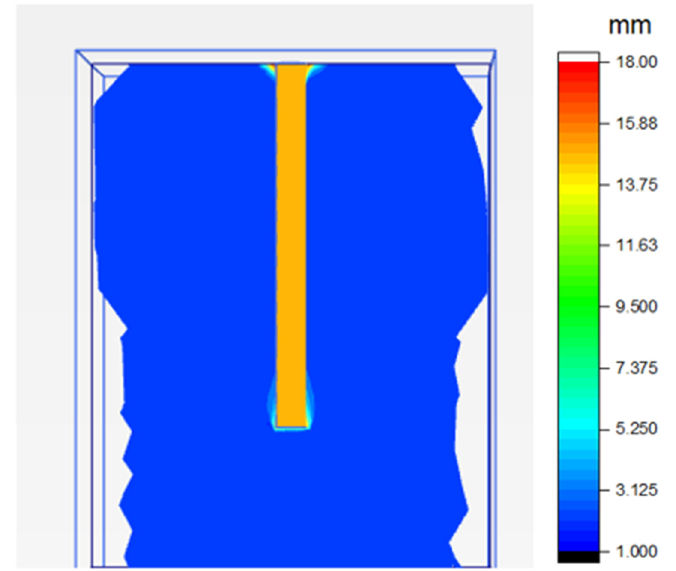
Figure 19. Displacement diagram of the pile during the uplift.